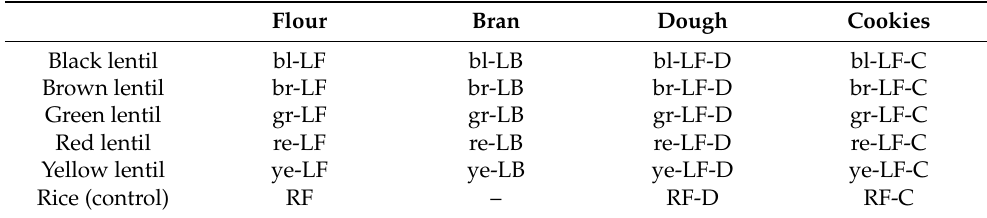
Table 2. Abbreviations used for lentil types and